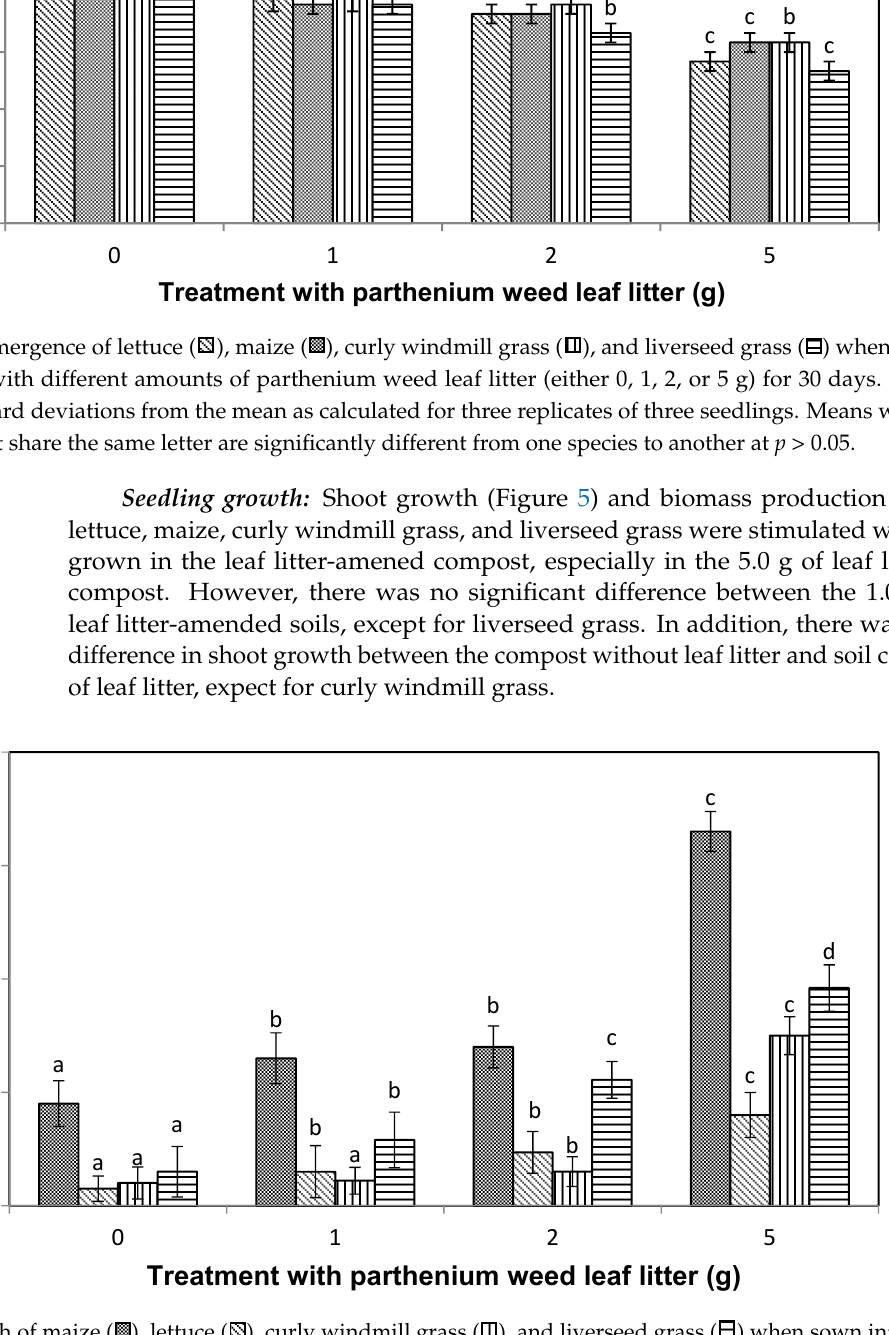
Figure 5. Shoot length of maize ( Figure 5. Shoot length of maize ( ), lettuce ( ), curly windmill grass ( ), and liverseed grass ( ) when sown into Figure 5. Shoot length of maize ( ), lettuce ( ), curly windmill grass ( ), and liverseed grass ( ) when sown into Figure 5. Shoot length of maize ( ), lettuce ( ), curly windmill grass ( ), and liverseed grass ( ) when sown into Figure 5. Shoot length of maize ( ), lettuce ( ), curly windmill grass ( ), and liverseed grass ( ) when sown into Figure 5. Shoot length of maize ( ), lettuce ( ), curly windmill grass ( ), and liverseed grass ( ) when sown into compost compost amended with different amounts of parthenium weed leaf litter (0, 1, 2, and 5 g) for 30 days. Error bars represent compost amended with different amounts of parthenium weed leaf litter (0, 1, 2, and 5 g) for 30 days. Error bars represent compost amended with different amounts of parthenium weed leaf litter (0, 1, 2, and 5 g) for 30 days. Error bars represent compost amended with different amounts of parthenium weed leaf litter (0, 1, 2, and 5 g) for 30 days. Error bars represent amended with different amounts of parthenium weed leaf litter (0, 1, 2, and 5 g) for 30 days. Error bars represent two two standard deviations from the mean as calculated for three replicates of three seedlings. Means within each treatment two standard deviations from the mean as calculated for three replicates of three seedlings. Means within each treatment two standard deviations from the mean as calculated for three replicates of three seedlings. Means within each treatment two standard deviations from the mean as calculated for three replicates of three seedlings. Means within each treatment standard deviations from the mean as calculated for three replicates of three seedlings. Means within each treatment that that do not share the same letter are significantly different from one species to another at p > that do not share the same letter are significantly different from one species to another at p > 0.05. that do not share the same letter are significantly different from one species to another at p > 0.05. that do not share the same letter are significantly different from one species to another at p > 0.05. do not share the same letter are significantly different from one species to another at p > 0.05.